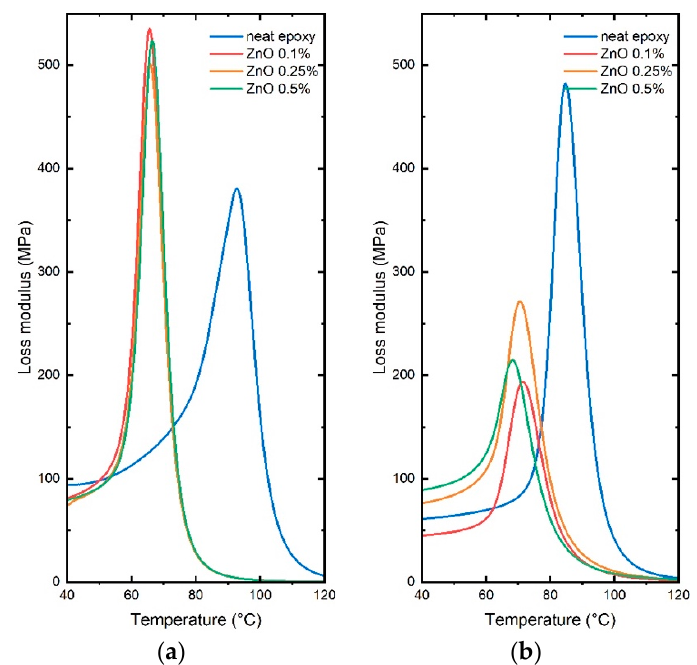
Figure 5. Loss modulus for ZnO-epoxy composite at 0.5 wt% ( a ) before and ( b ) after UV and gamma irradiation.